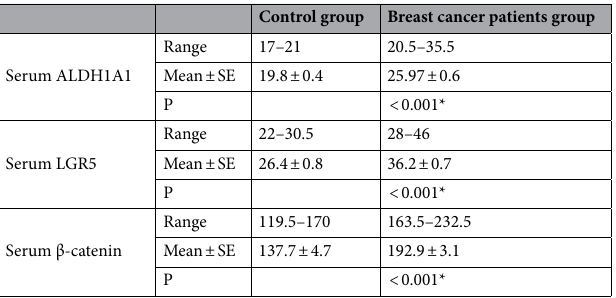
Table 3. Statistical analyses of serum ALDH1A1, LGR5 and β-catenin levels (pg/ml) in control group and BC patients group. P P value for comparing between control group and BC patients group. *Statistically significant difference at P ≤